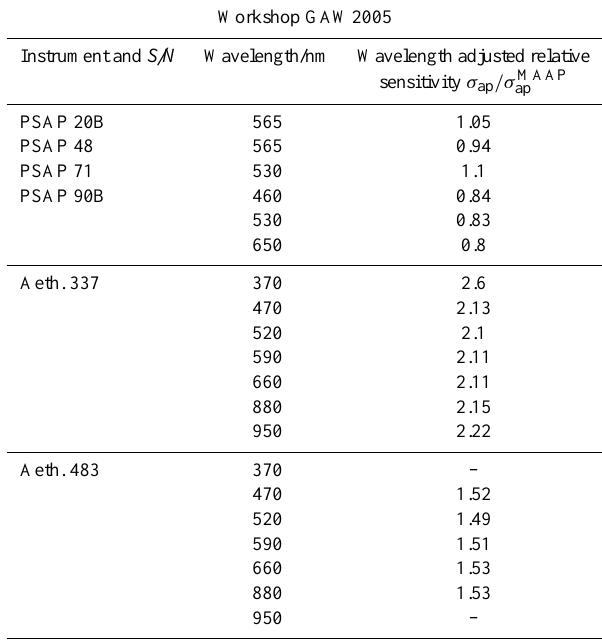
Relative responses to carbon black. PSAP and Aethalometer data were corrected according to Bond et al. (1999) and Weingartner et al.